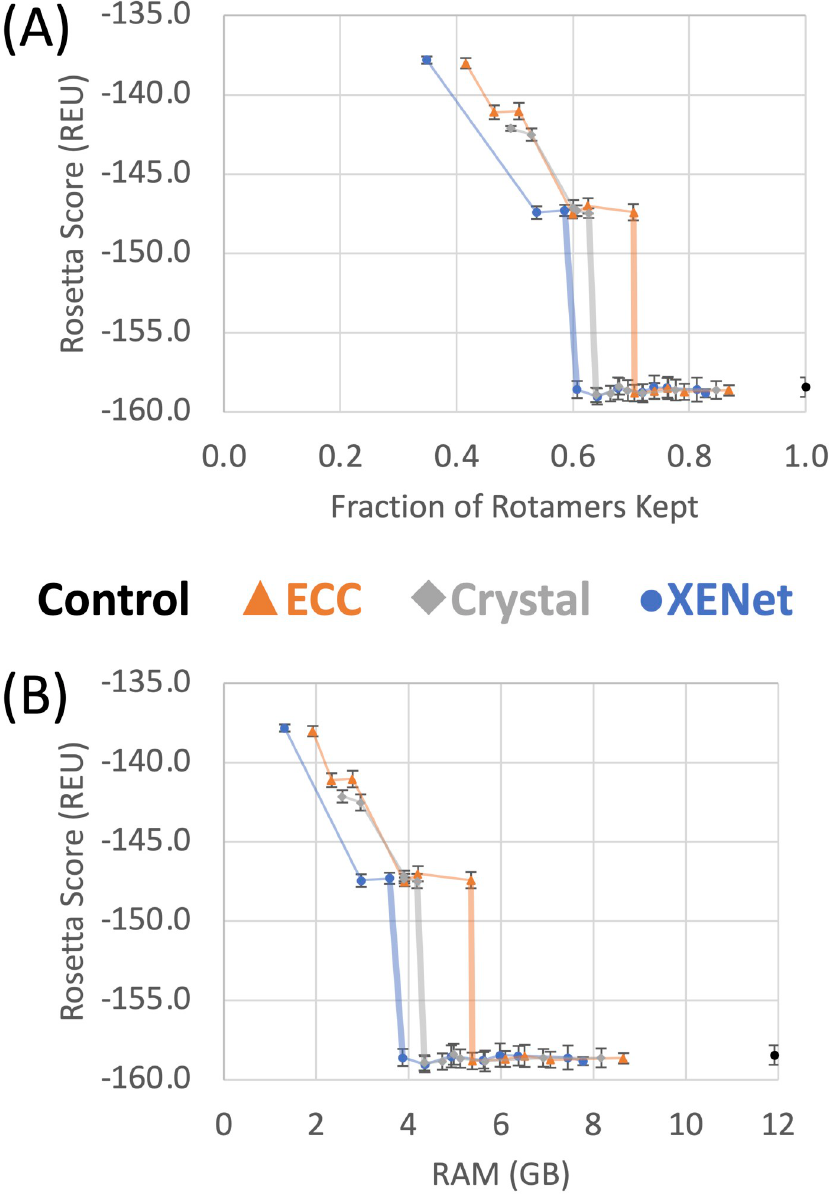
Fig 3. Quantum FixbbGCN benchmark results. (A) Mean Rosetta Scores for various cutoffs and convolutions types. Lines connect points of the same convolution and the line to the first drop in design quality is drawn thick. X-axis values are the number of surviving rotamers for a cutoff/convolution pair divided by the number of rotamers in the control case. (B) Same results as (A) but plotting against annealer memory usage instead of rotamer count. Both y-axes are truncated for the sake of